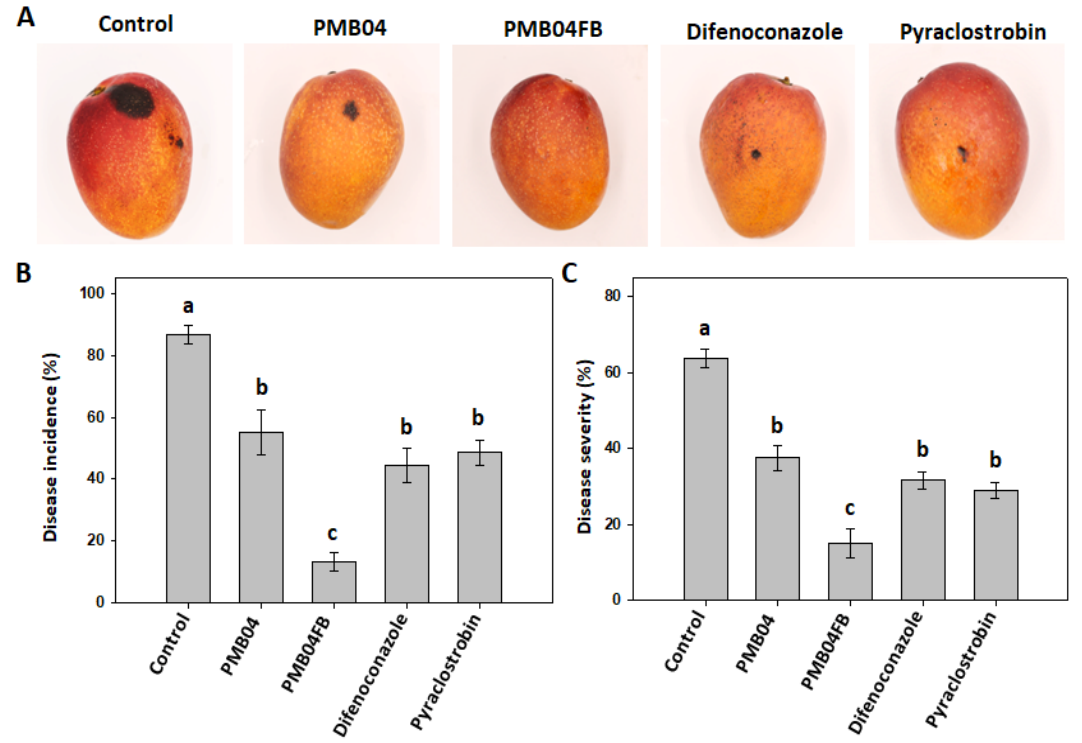
Figure 4. Application of Bacillus amyloliquefaciens PMB04 fermentation broth and fungicides against anthracnose disease in mango fruit. ( A ) shows the symptom appearances of the different treatments on fruit at 7 days post-inoculation. The surfaces of sterilized fruit were soaked in the 200-fold dilution of B. amyloliquefaciens PMB04 fermentation broth (PMB04FB), 16.6 mg ai mL − 1 difenoconazole, or 7.8 mg ai mL − 1 pyraclostrobin for 1 min as the treatment. The control was performed with sterilized water as a negative control. A spore suspension of Colletotrichum gloeosporioides was then spotted on the surface of the fruit for inoculation. ( B , C ) show the disease incidence and disease severity at 7 days post-inoculation, respectively. Data represent mean ± SD. Different letters above the columns indicate significant differences based on Tukey’s HSD test (The F value for disease incidence and disease severity were 46.0 and 43.8, respectively. p < 0.05).